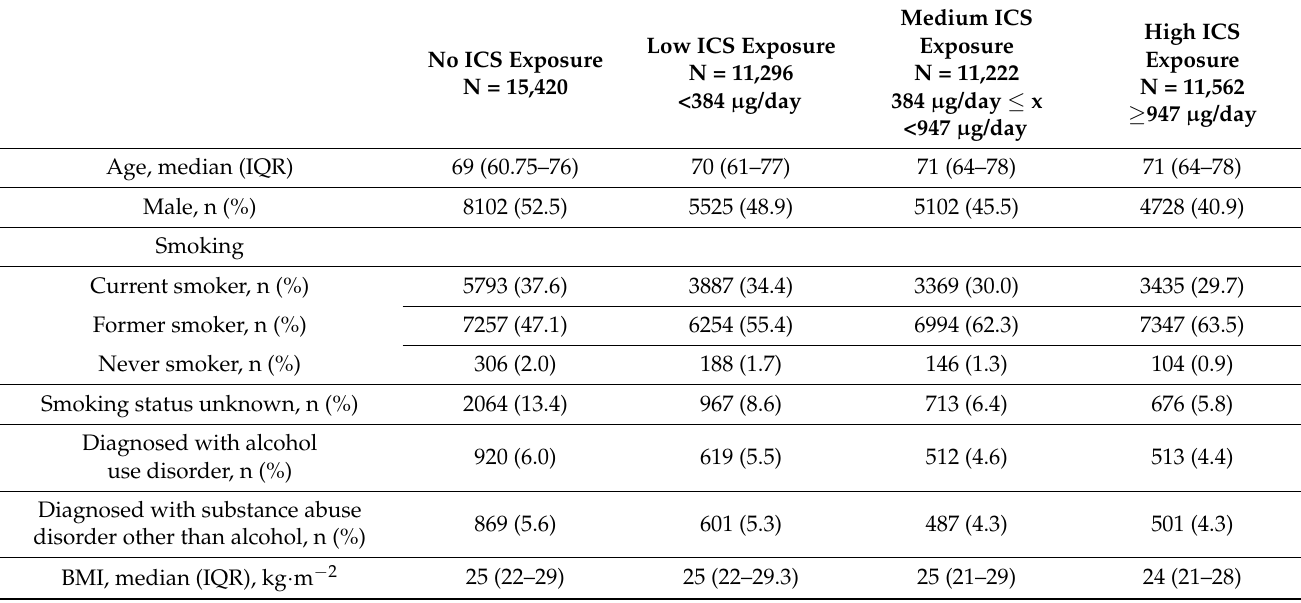
Figure 1. Flow diagram for the study population. Patients with at least 1 outpatient clinical visit between 1st of January 2010 and 31st of October 2017 were included from the Danish register for COPD (DrCOPD). Patients younger than 40 years old or with cancer other than basal cell carcinoma of the skin were excluded. Patients were divided into four groups on the basis of the accumulated ICS dose one year prior to entering the cohort. Abbreviations: CIS: carcinoma in situ. ICS: Inhaled corticosteroid. Table 1. Baseline characteristics of the COPD outpatients between 1 January 2010 and 31 February